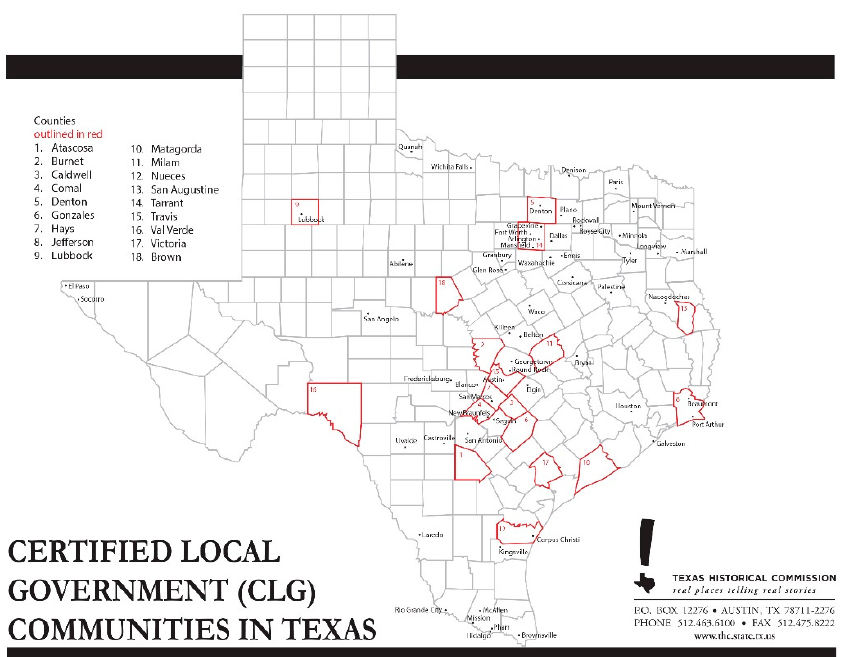
Figure 1. This July 2020 map contains 77 cities and counties considered Certified Local Government Communities. Source: https://www.thc.texas.gov/preserve/projects-and-programs/certified-local-government/certified-local-government-communities